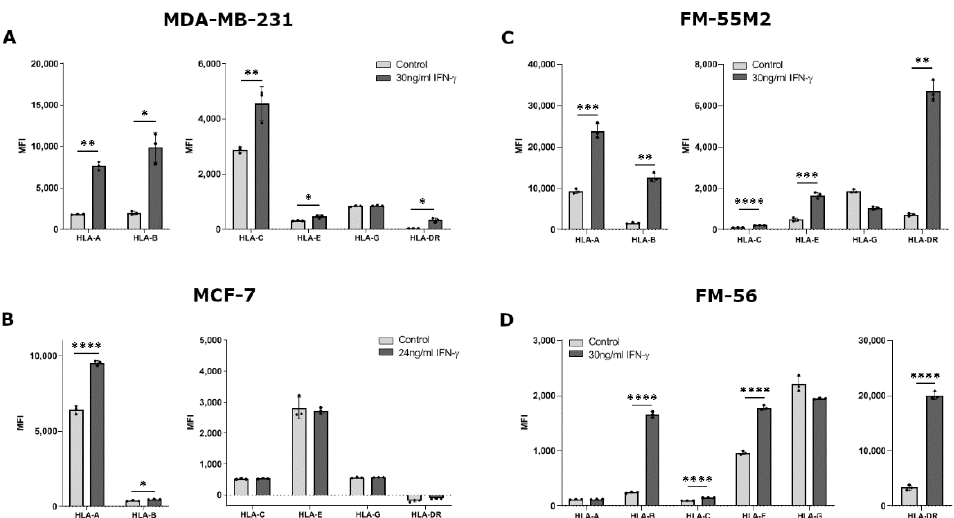
Figure 1. Human leukocyte antigen (HLA)-G surface expression on cancer cell lines. Representative histograms showing the expression of HLA-G on untreated cells compared to an isotype control. MDA-MB-231, MCF-7, FM-55M2, and FM-56 cell lines are HLA-G-negative, whereas JEG-3 cells are HLA-G-positive. Filled grey: Cells stained with isotype antibody as a negative control for HLA-G expression; solid black: Untreated cells stained with anti-HLA-G antibody.